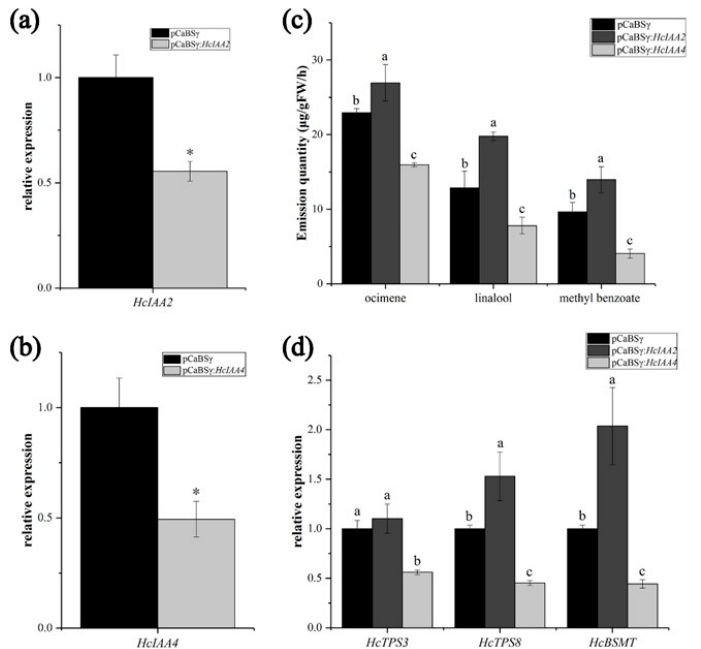
Figure 9. Silencing of HcIAA2 and HcIAA4 alters the amount of the main volatile compounds in flowers. ( a, b ) Expression of the HcIAA2 and HcIAA4 genes in barley stripe mosaic virus (BSMV)- HcIAA2/4 -silenced and control flowers were analyzed by qRT-PCR. ( c ) GC–MS analysis of main volatile compounds of H. coronarium flower. ( d ) Expression analysis of key volatile biosynthesis genes in BSMV- HcIAA2/4 -silenced vs. control flowers by qRT-PCR. The results are the means of three biological replicates with standard deviations. Asterisks indicate statistically significant differences (Student’s t -test, * p < 0.05).